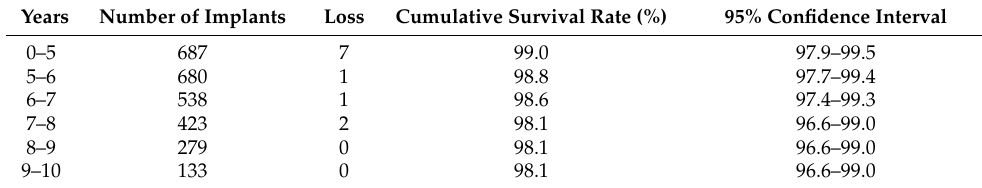
Table 4. The cumulative survival rates of implants up to 10 years.